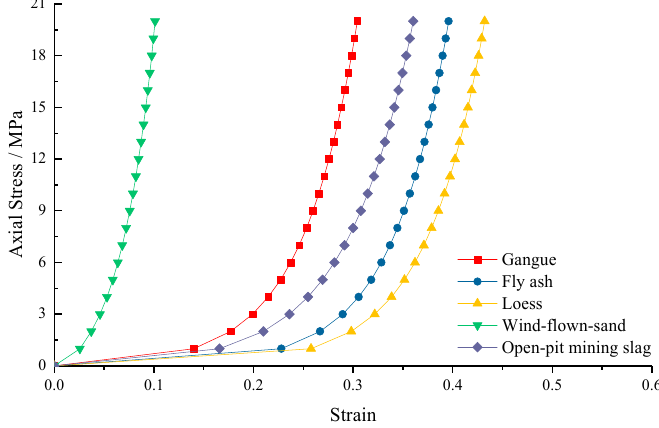
Figure 6. Stress–strain relationships for different granular backfill materials.